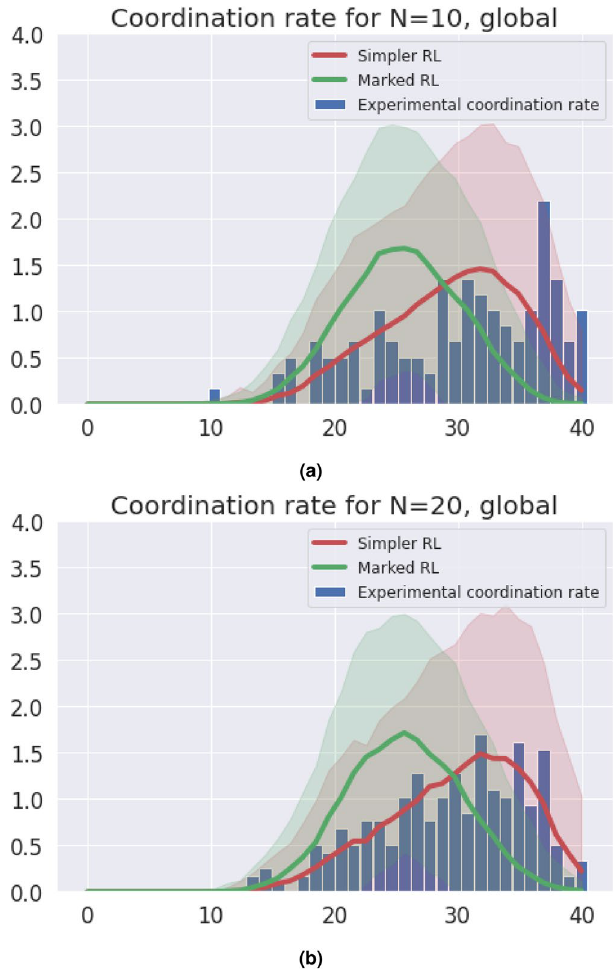
Figure 8. ( a ) Coordination rate distribution for the sum of the populations with N = 10 for the rounds (0, 40). ( b ) Coordination rate distribution for the sum of the populations with N = 20 for the rounds (0,